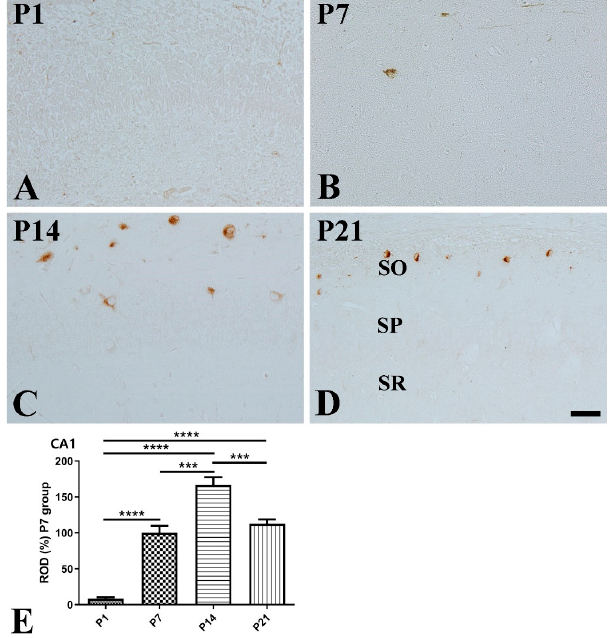
Figure 2. Immunohistochemical staining for somatostatin (SST) in the mouse hippocampal CA1 region at P1 ( A ), P7 ( B ), P14 ( C ), and P21 ( D ). SO stratum oriens; SP stratum pyramidale; SR stratum radiatum. Scale bar = 50 µm. ( E ): The number of SST-immunoreactive cells in the hippocampal CA1 region at P1, P7, P14, and P21 are expressed as a percentage of the values in the P7 group ( n = 5 per group; *** p < 0.001 and **** p < 0.0001). All data are represented as the mean ± standard error of the mean.